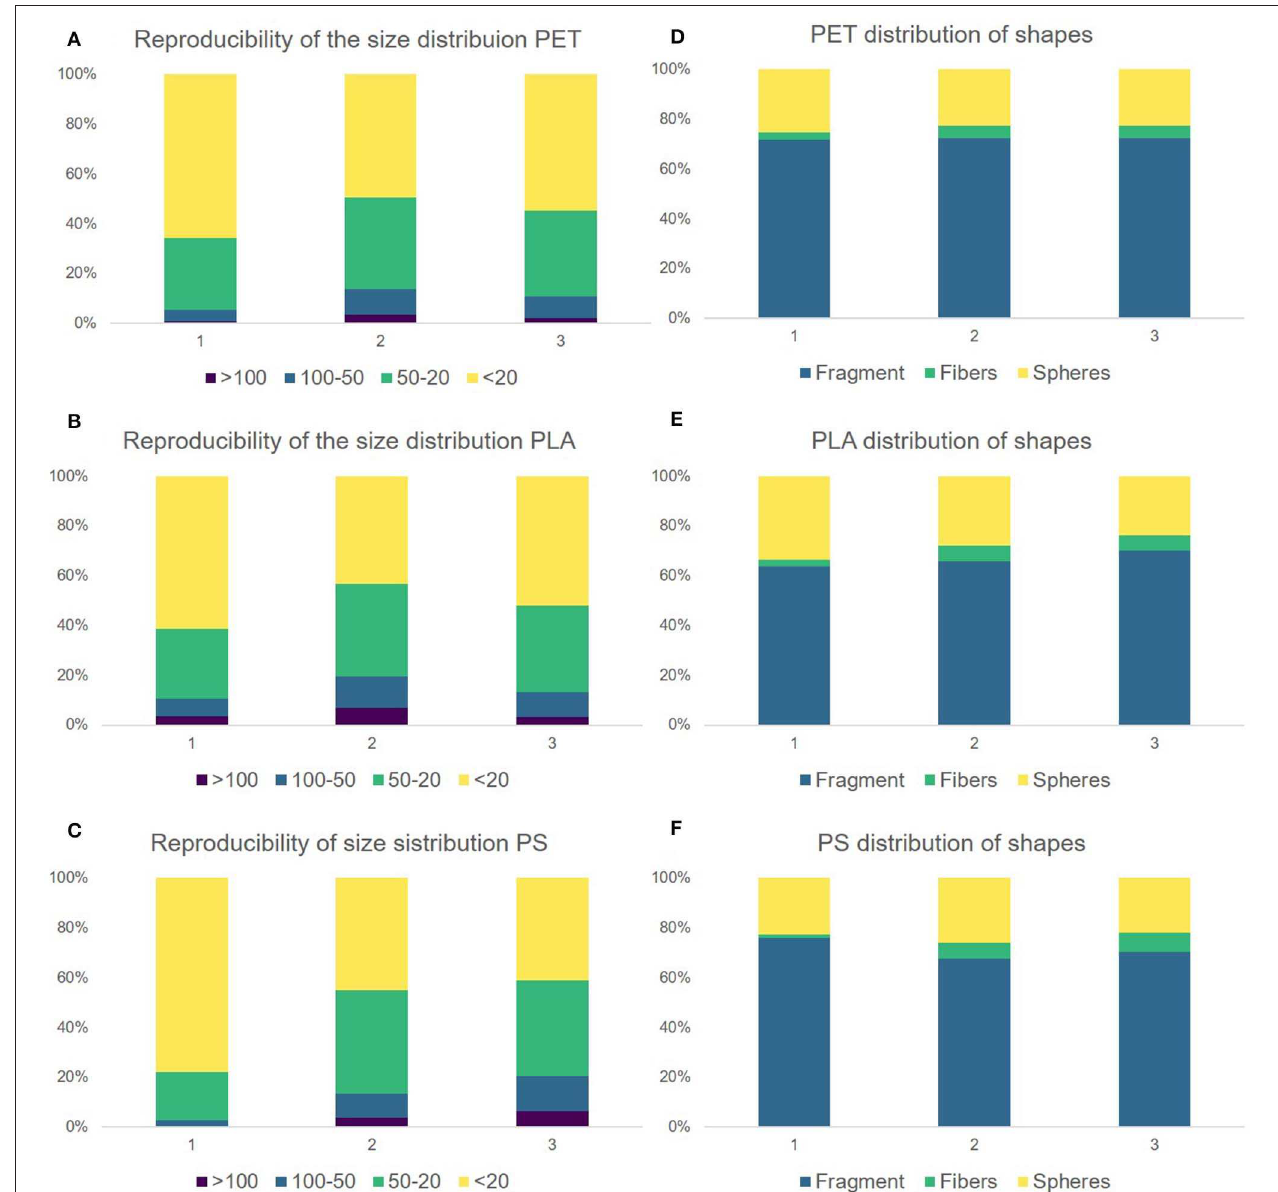
FIGURE 6 | Comparison of the replicates 1–3. Replicate 1 was produced by operator 1 and replicates 2 and 3 were produced by operator 2. Reproducibility of the size distribution for PET (A) , PLA (B) , and PS (C) . Distribution of particle shapes for PET (D) , PLA (E) , PS (F) . The corresponding data can be viewed in SI Table 1